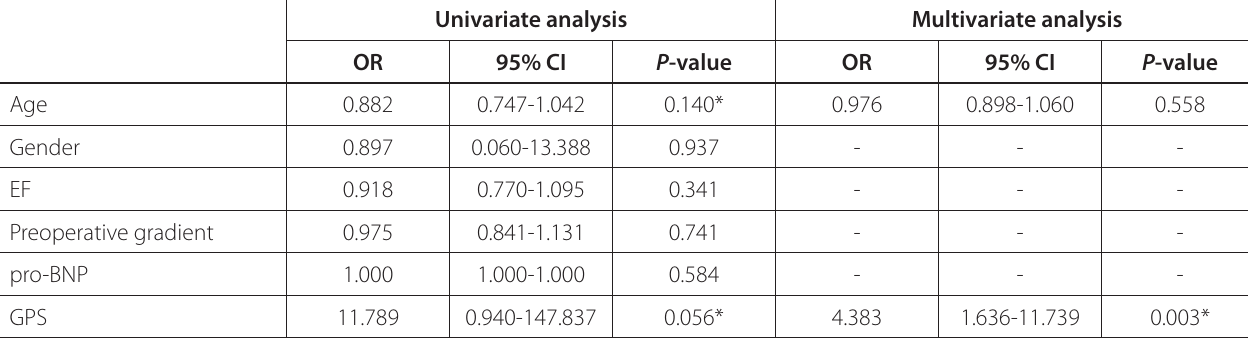
Table 3 . Univariate and multivariate analysis of prognostic factors associated with primary endpoints in patients who underwent